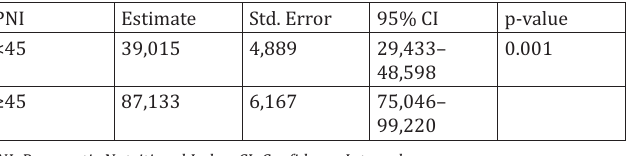
Comparison of overall survival for PNI based on a Kaplan-Meier